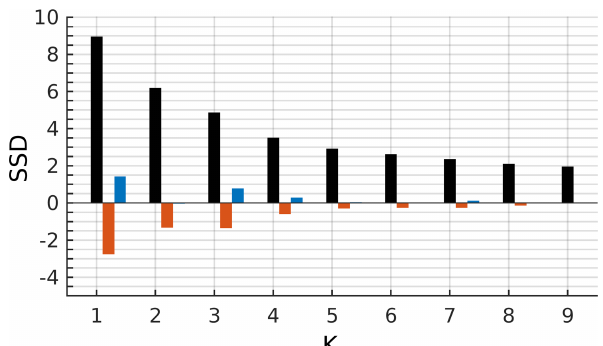
Figure 4. Sum of square distances (black bars) between the normal- ized pairs of error points and their designated centroids for differ- ent numbers of initial centroids. The first-order (red bars) and the second-order (blue bars) forward differences calculated from the sum of square